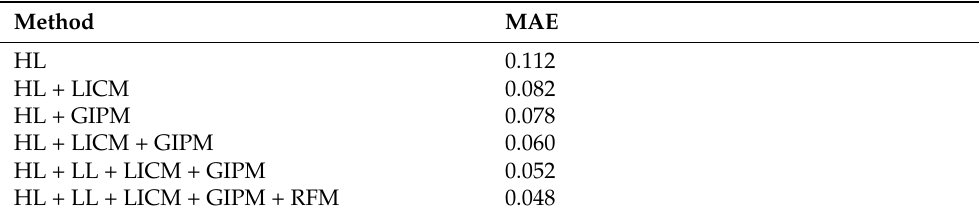
Table 4. Ablation evaluations using different components combinations. LL and HL represent low-level features and high-level features, respectively.